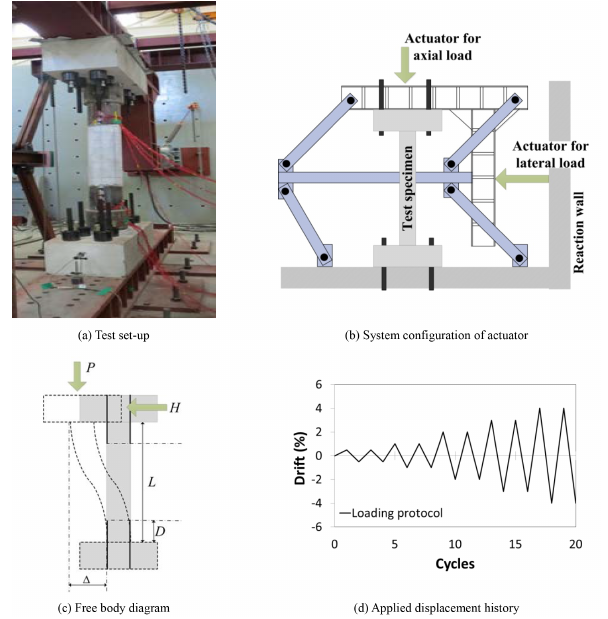
Figure 14. Test set-up details with actuator and cyclic load.